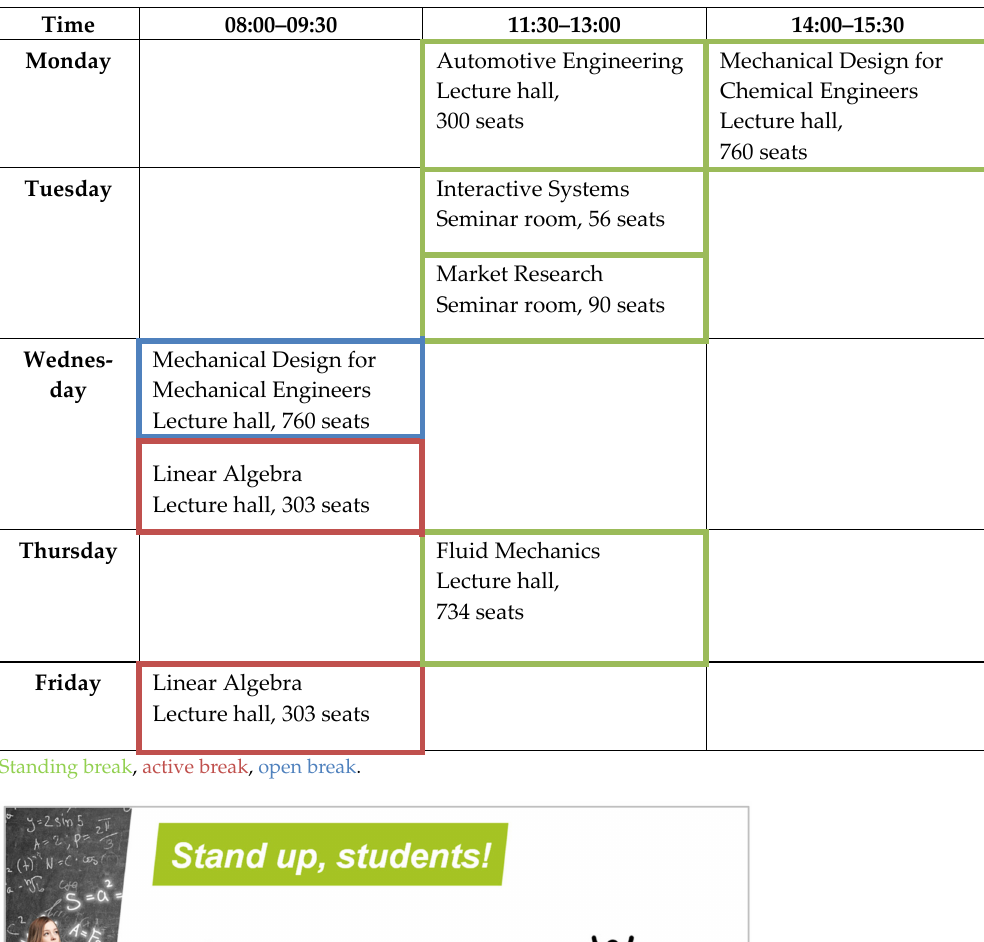
Table 1. Lectures of study.